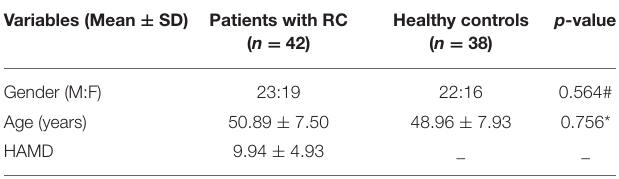
TABLE 1 | Demographic and clinical characteristics of